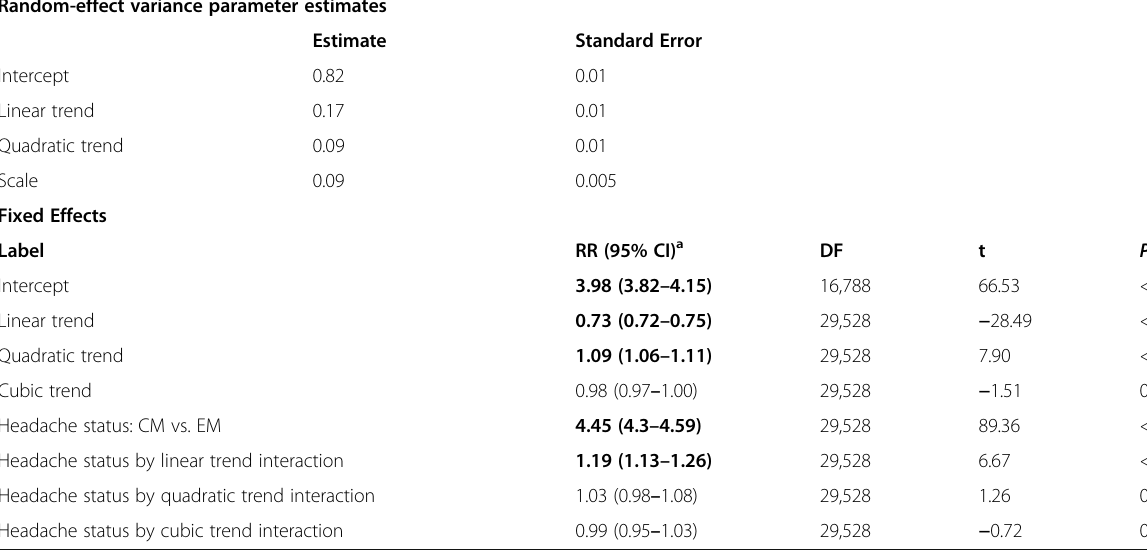
Table 2 Unadjusted model for headache days per month for persons with EM and CM Random-effect variance parameter